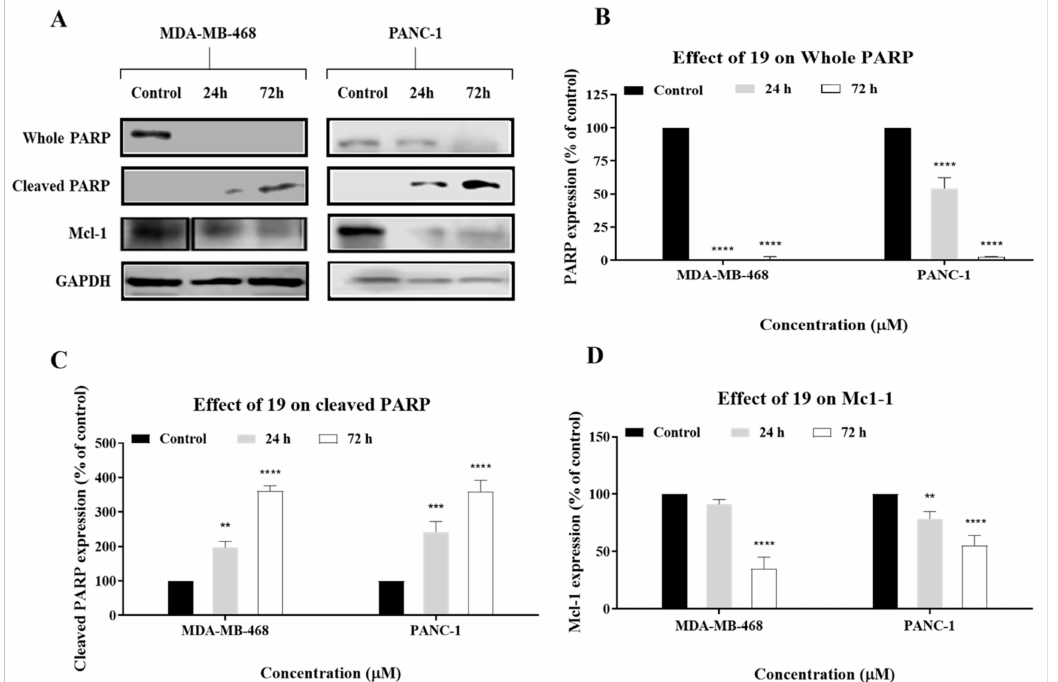
Figure 10. ( A ) Western blot analysis of PARP, cleaved PARP, and Mcl-1 in MDA-MB-468 and PANC-1 cells. Cells were treated with 19 for 24 h and 72 h at a concentration of 2 × GI 50 . GAPDH was used as an internal control. ( B – D ) Collated densitometric measurement of protein expression levels in MDA-MB-468 and PANC-1 cells. The experiment was repeated at least three times. Bars and error bars refer to the mean ± SD. ** p < 0.01 vs. control, *** p < 0.001 vs. control, **** p < 0.0001 vs.